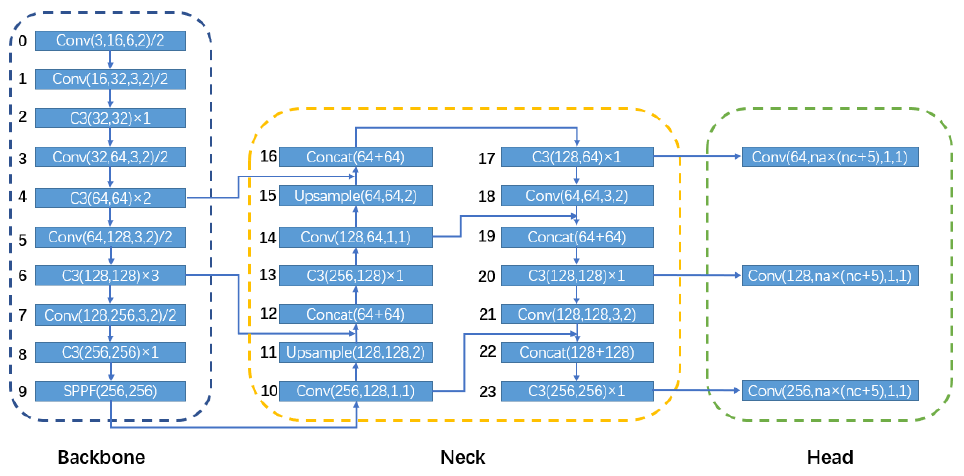
Figure 5. YOLOv5n network structure.